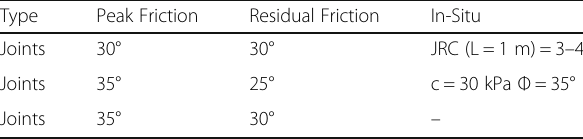
Table 3 Shear parameters of the discontinuities